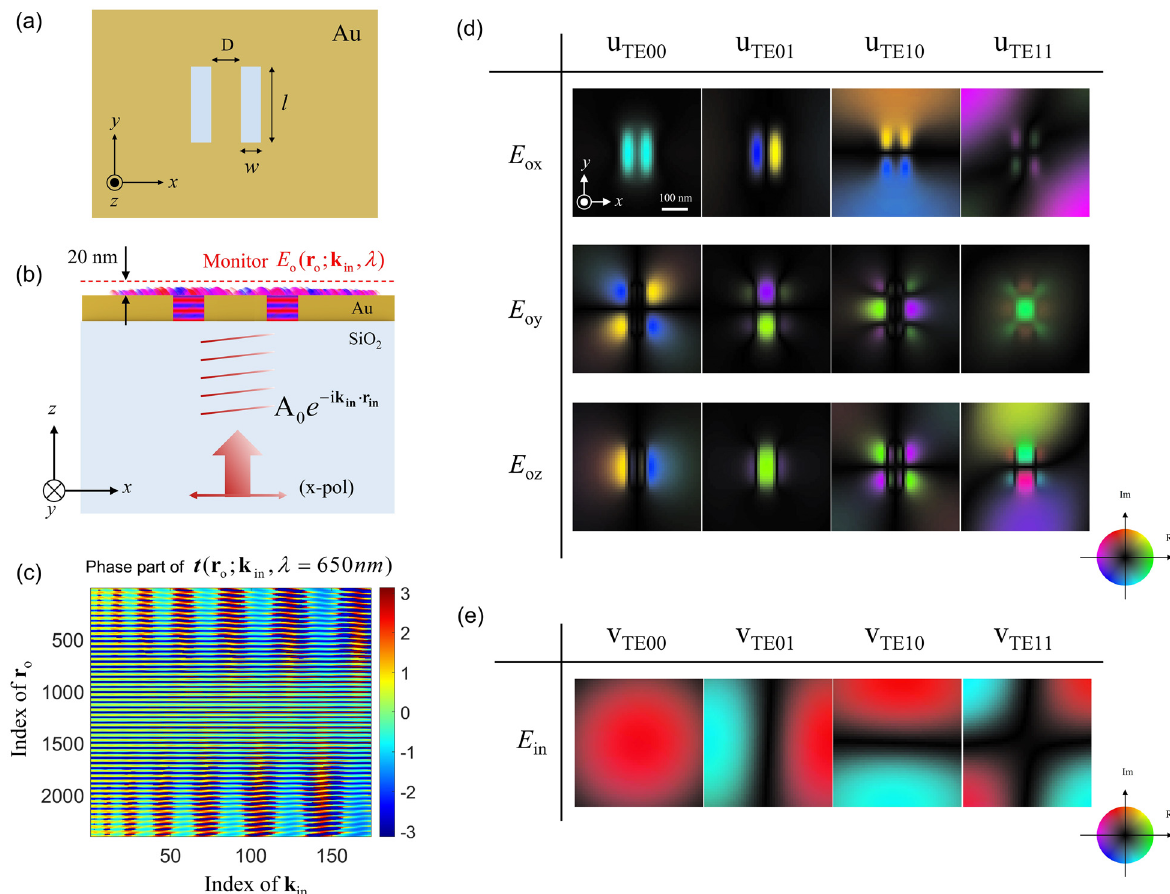
Figure 4: T-matrix-based mode analysis for double-slot nanoantenna. (a) and (b) Simulation schematics of double-slot nanoantenna in xy - and zx -planes, respectively. Here, the slot width ( w ), length ( l ), and spacing ( D ) are 20, 160, and 50 nm, respectively. (c) Phase part of T-matrix constructed from the near- fi eld complex- fi eld maps obtained at wavelength650nm.Thecolumnindexindicates k in sortedinincreasingorderofitsmagnitude.Therowindexdescribes r o sortedinincreasing order of its magnitude. Only the phase part of the T-matrix is shown. (d) Electric fi elds of x , y , and z components of the double-slot nanoantenna. (e) Electric fi eld of input beam for the excitation of each eigenmode. Circular color maps: real and imaginary values of the complex fi